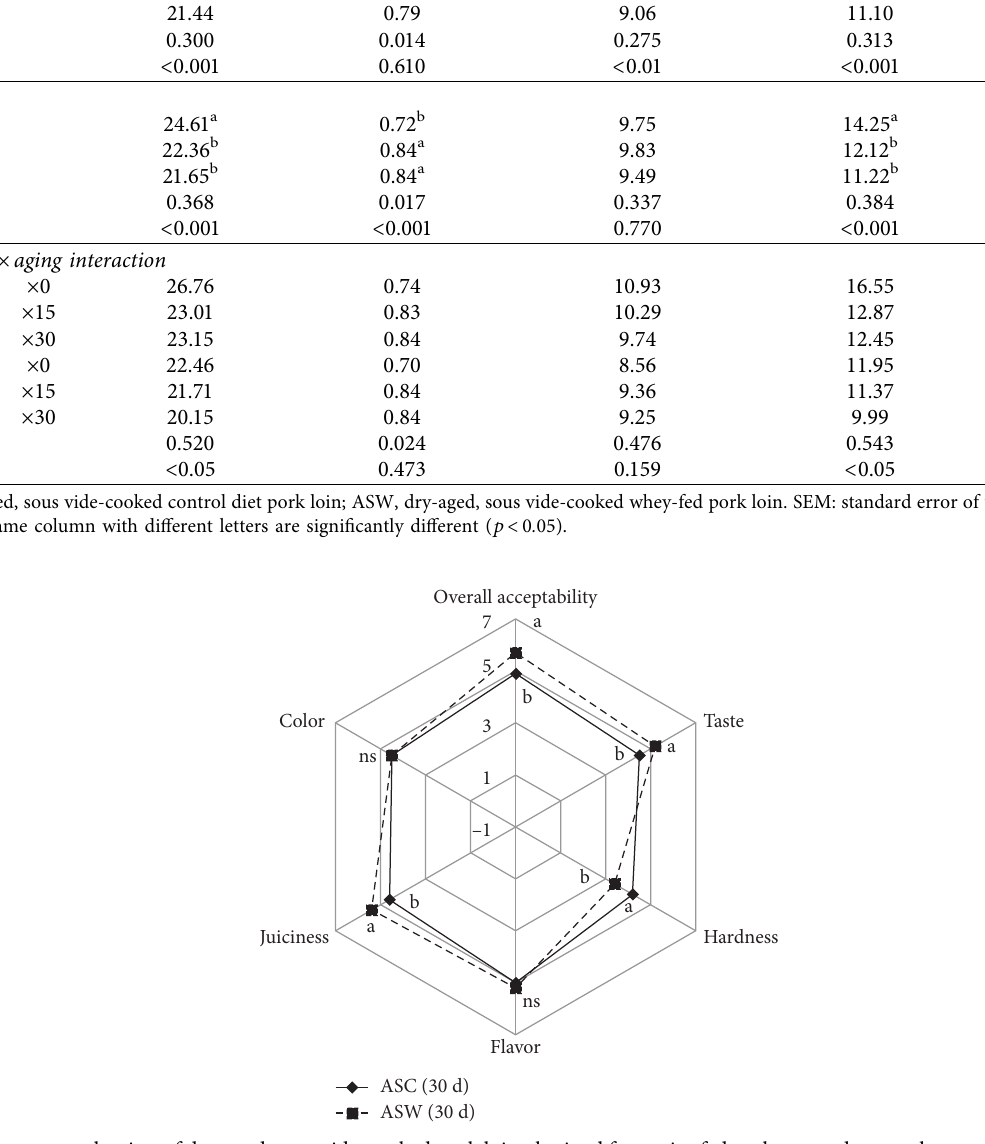
Figure 2: Sensory evaluation of dry-aged, sous vide-cooked pork loin obtained from pigs fed a whey powder-supplemented diet. ASC, dry- aged, sous vide-cooked control diet pork loin; ASW, dry-aged, sous vide-cooked whey-fed pork loin. Means with different labels (a, b) differ significantly ( p < 0 .